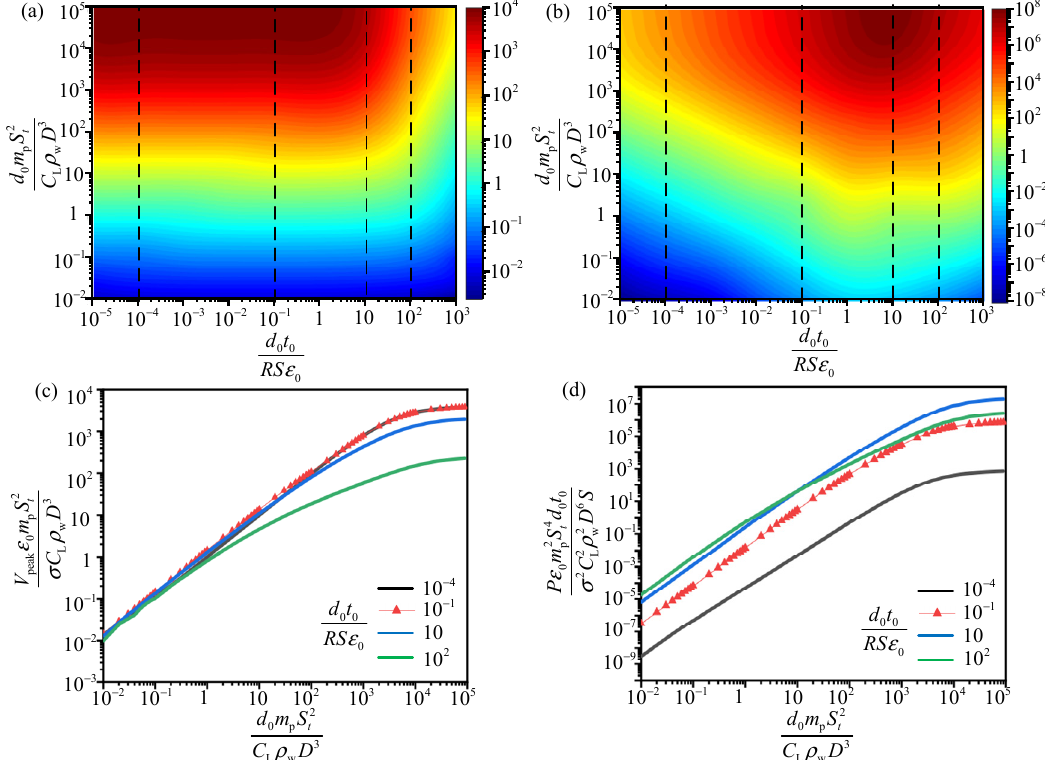
Figure 11. Analysis of the output performance ideal energy harvesting system with dimensionless parameters. ( a , b ) are power maps for the two dimensionless parameters d 0 t 0 . The color represents the dimensionless peak voltage V n1 and average power P n1 , respectively. ( c , d ) show restricted optimization voltage and power versus d 0 m p S with average power RS ε 0 n1